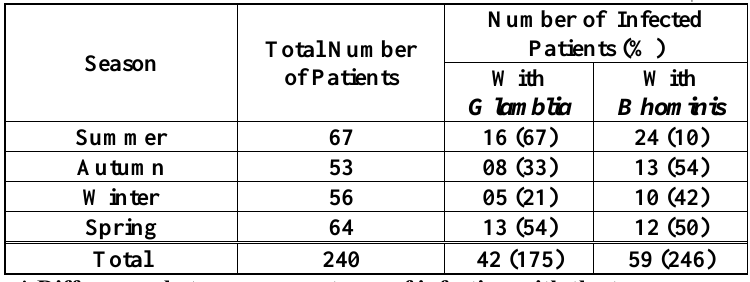
Table (3): Number and percentage of patients infected with G. lamblia and B. hominis within the seasons† Number of Infected Patients (%) Total Number Season of Patients With With G lamblia B hominis Summer